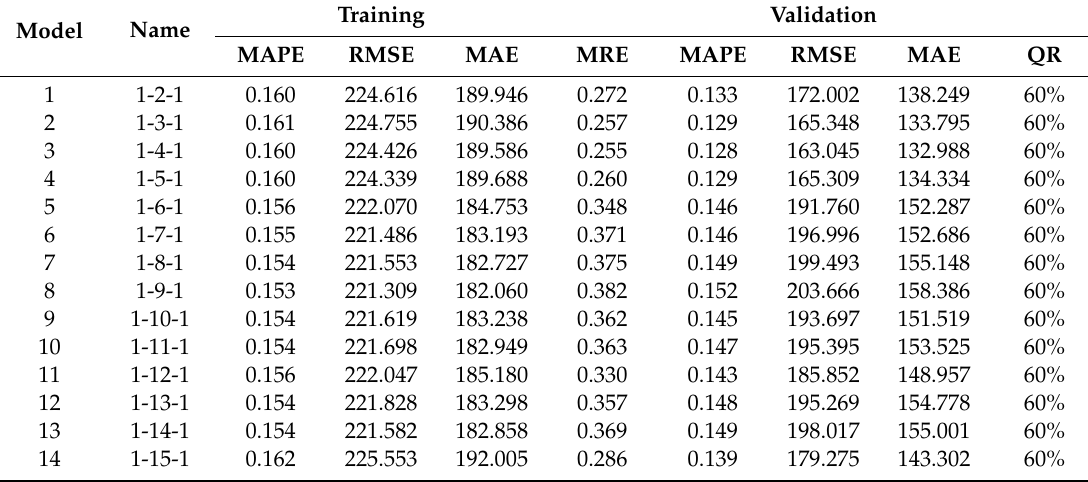
Table 4. With the first principal component as input, the performance of the Elman Neural Network with di ff erent hidden layer nodes.